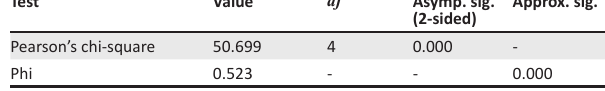
TABLE 8: Brainstorming versus perceived decision-making success. Test Value df Asymp. sig.